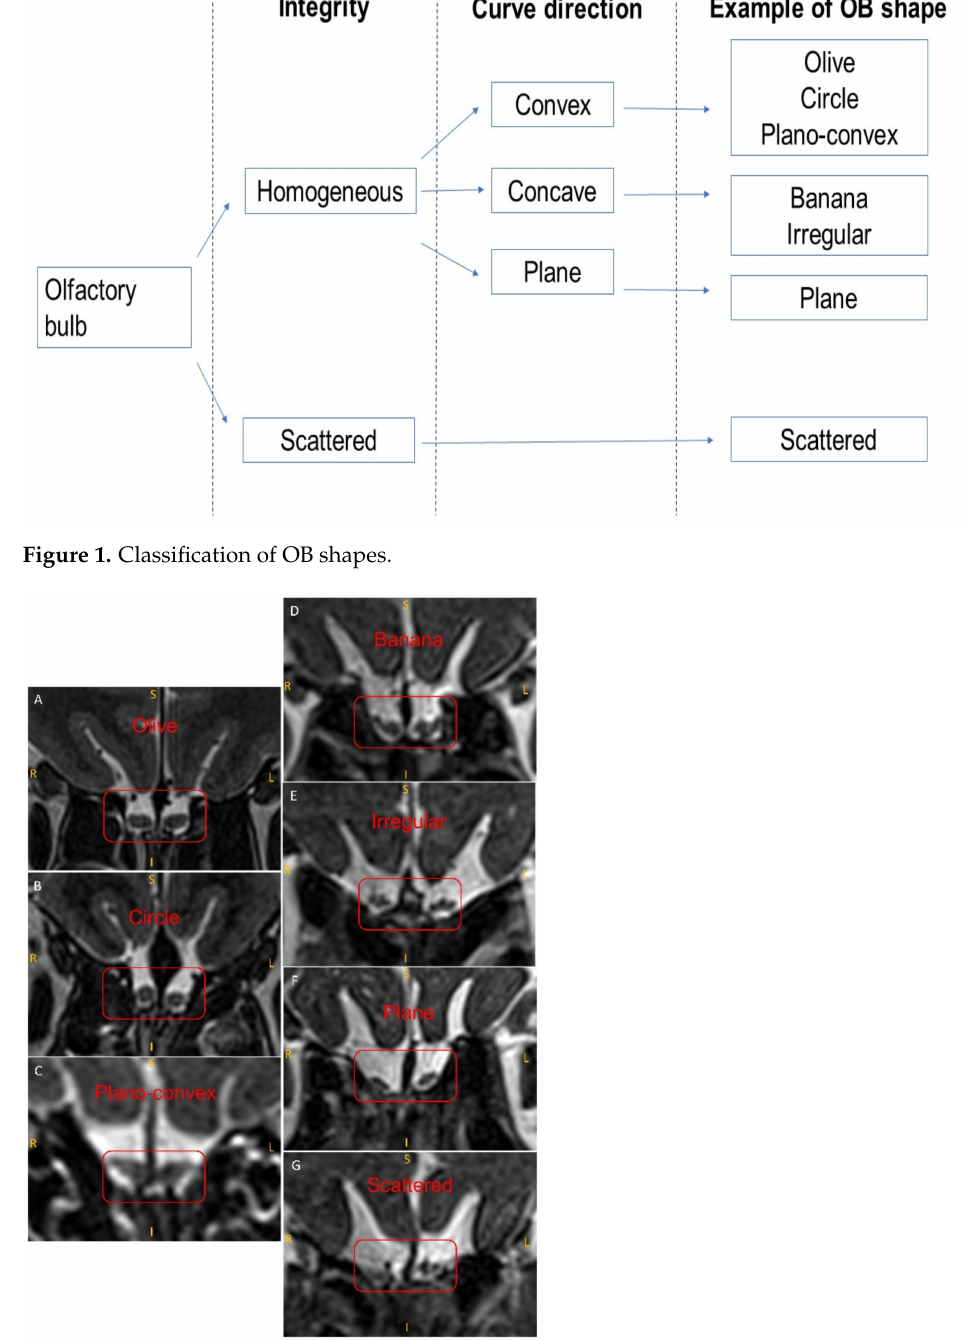
Figure 2. OB shapes are shown in the coronal T2-weighted MR image (red box) (R-Right, L-Left, S-Superior/Dorsal, I-Inferior/Ventral). ( A ) 23-year-old female healthy control (TDI = 37.25) with an olive-shaped OB; ( B ) 31-year-old healthy male control (TDI = 33.5) with circular OB; ( C ) 55-year-old woman with post-viral olfactory function (TDI = 12) demonstrating plano-convex OB; ( D ) 55-year-old man with post-viral olfactory function (TDI = 15) demonstrating banana-shaped OB; ( E ) 57-year-old woman with post-traumatic olfactory function (TDI = 23) showing irregular OB; ( F ) 54-year-old woman with post-viral olfactory function (TDI = 15) demonstrating plane OB; ( G ) 89-year-old woman with post-viral olfactory function (TDI = 20.5) demonstrating scattered OB. TDI = Threshold-